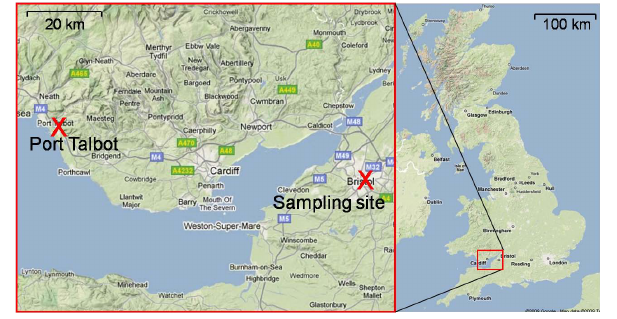
Fig. 1. Sampling site location in Bristol’s city centre in the United Kingdom and the location of Port Talbot to the west of the